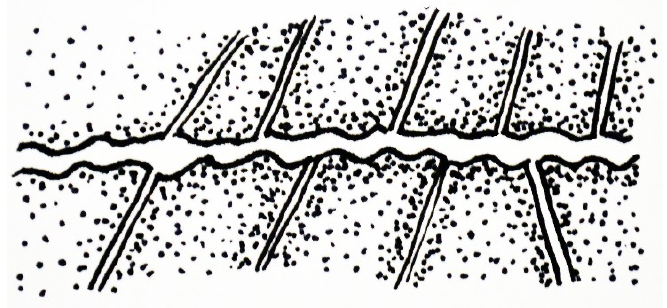
Figure 23. Shenzianyuloma yunnanense nov. gen. nov. sp. IGM 5008. Detail of alimentary tract and gut diverticula at the anterior end of preserved gut trace. Width of view 700 microns. Image Credit: Mark McMenamin.